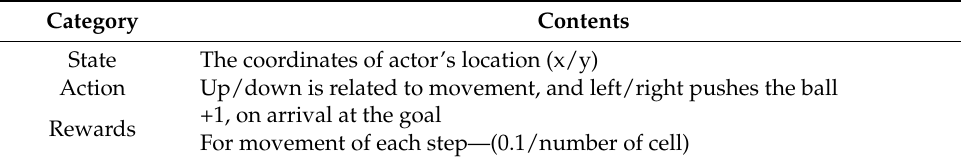
Table 3. Object of learning in the maze game.